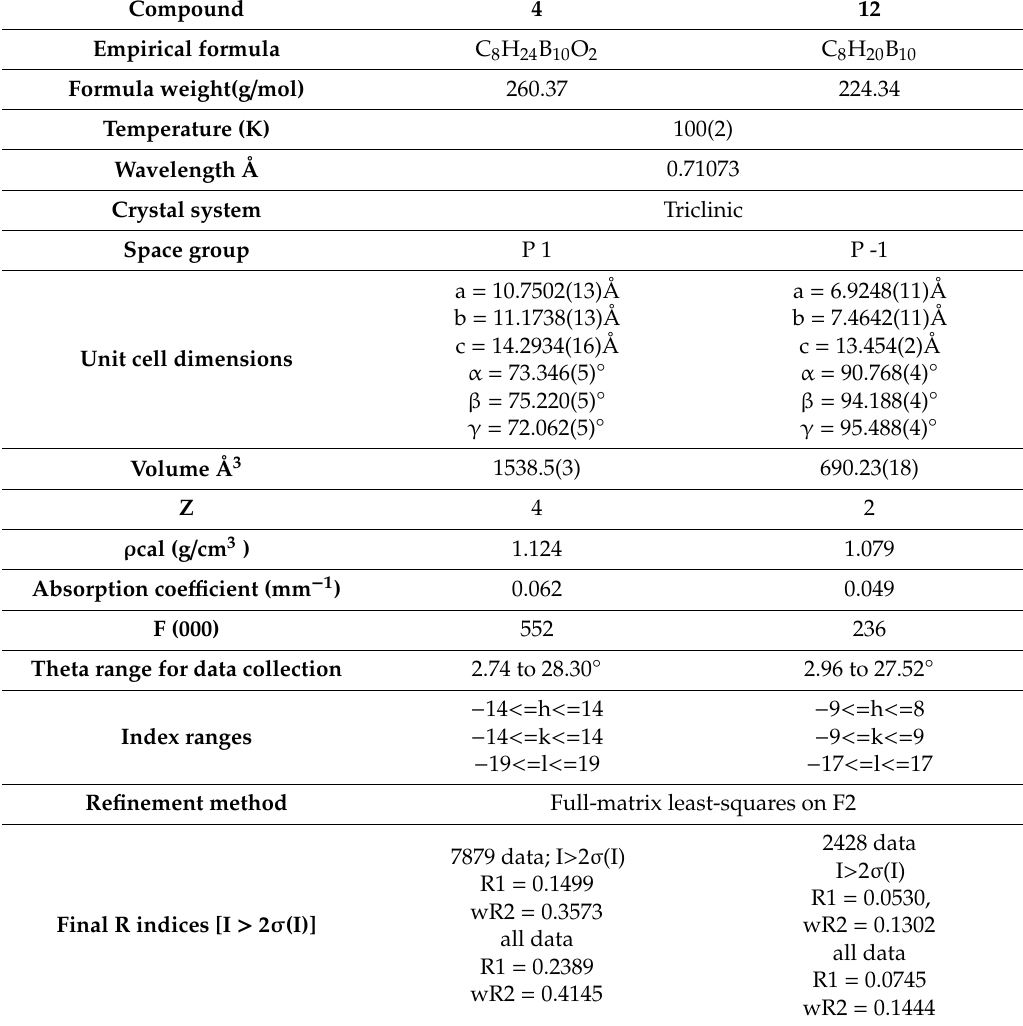
Figure 5. ORTEP presentation of 9,10-(HOCH 2 CH 2 CH 2 ) 2 -1,7- closo -C 2 B 10 H 10 ( 4 ) and 9,10-(CH 3 CH = CH) 2 -1,7- closo -C 2 B 10 H 10 ( 12 ) showing the atom numbering and displacement. Ellipsoids are at 30% and 50% probability level, respectively. Table 6. Crystal data and structure refinement.